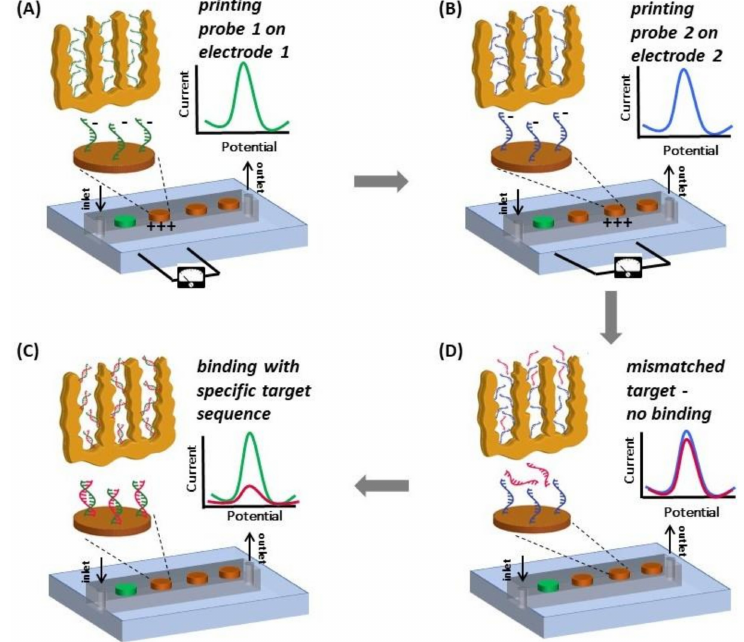
Figure 1. Scheme illustrating the concept of electrically-guided DNA grafting (note that the